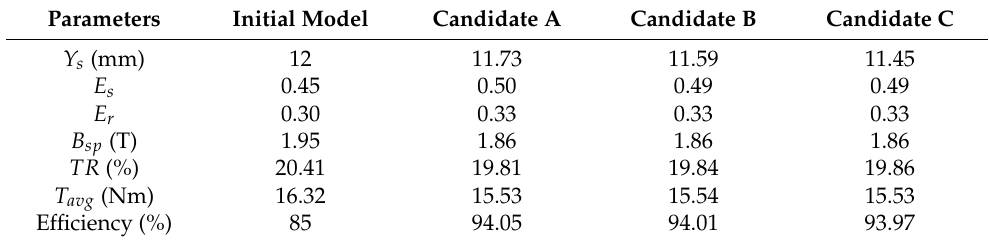
Table 5. Parameters of the initial model and optimal candidates at rated conditions .